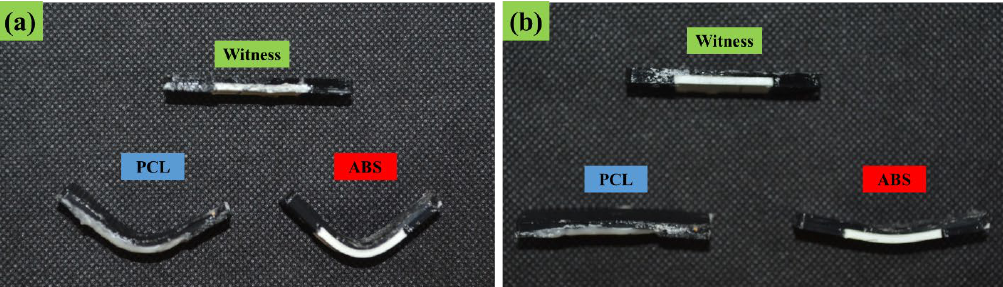
Figure 8. Visual comparison of shape memory properties for two structures of ABS–TPU and PCL–TPU composite structures: ( a ) shape fixity and ( b ) shape recovery.